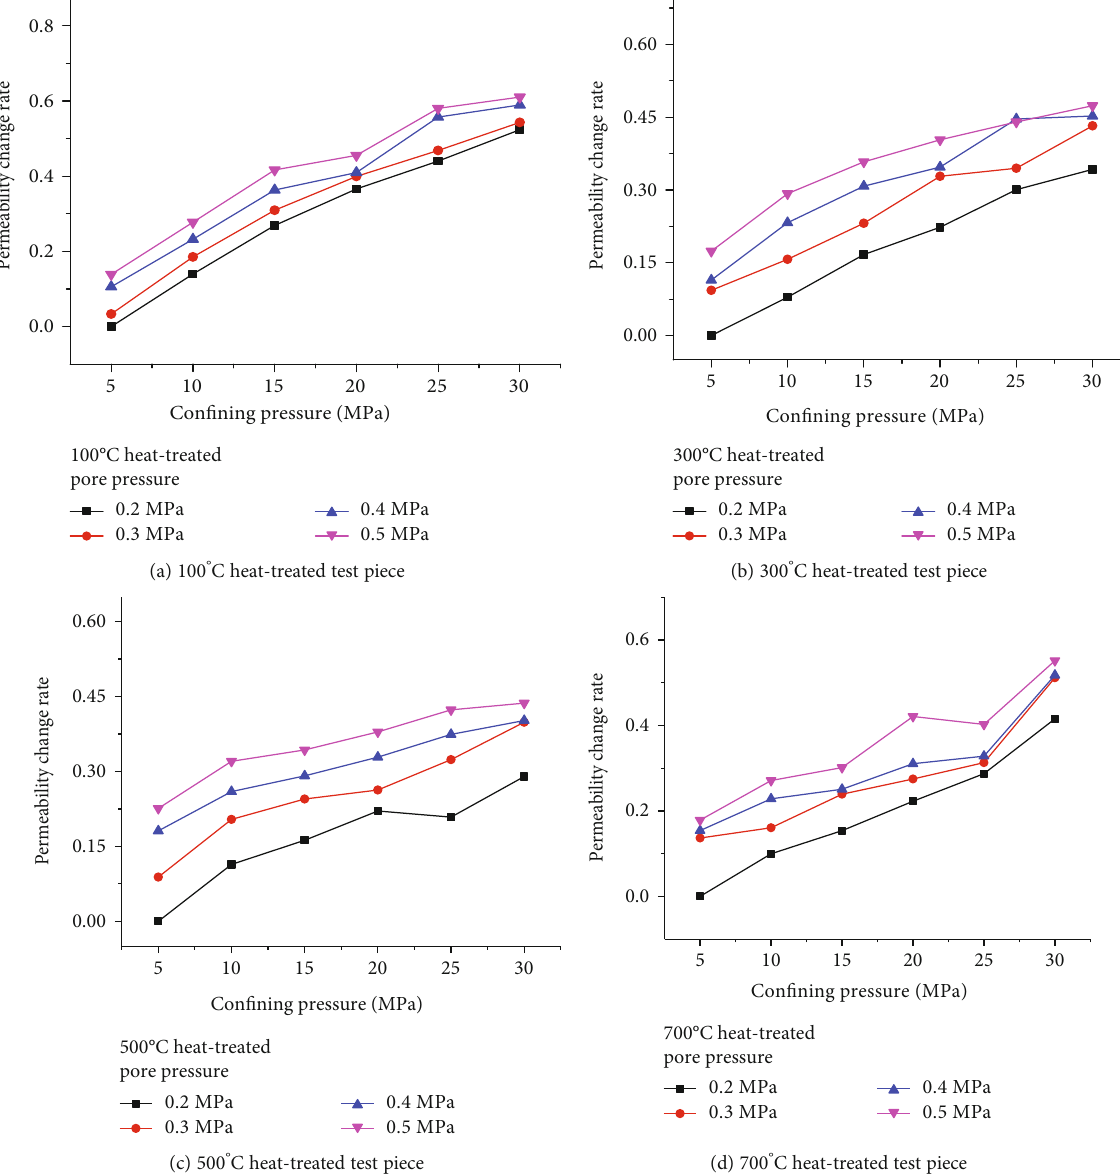
Figure 6: Permeability change rate curves under the di ff erent con fi ning pressure